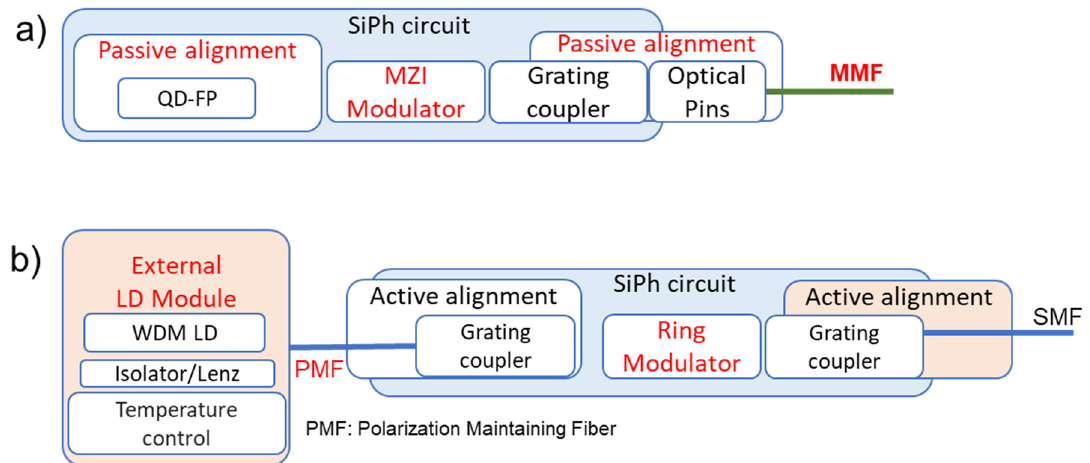
Figure 6. Functional block comparison of different laser integration schemes. ( a ) Integrated laser scheme in single wavelength IOCore micro-transceiver with multimode fiber; ( b ) high-end WDM silicon photonics transceiver with external multiwavelength laser source.